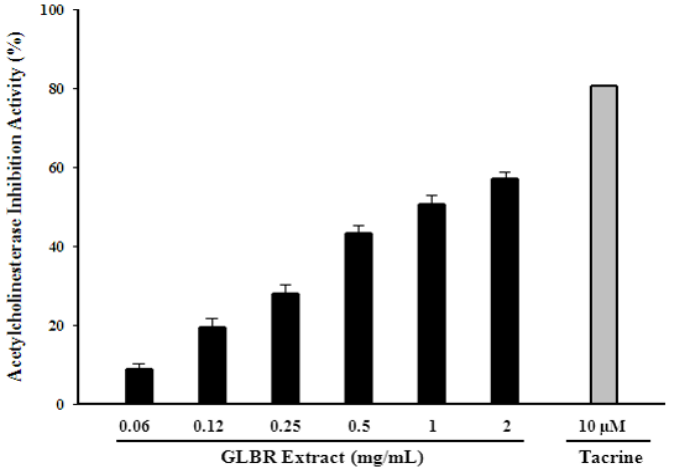
Figure 2. Acetylcholinesterase (AChE) inhibitory activity of Ganoderma lucidum grown on germinated brown rice (GLBR)